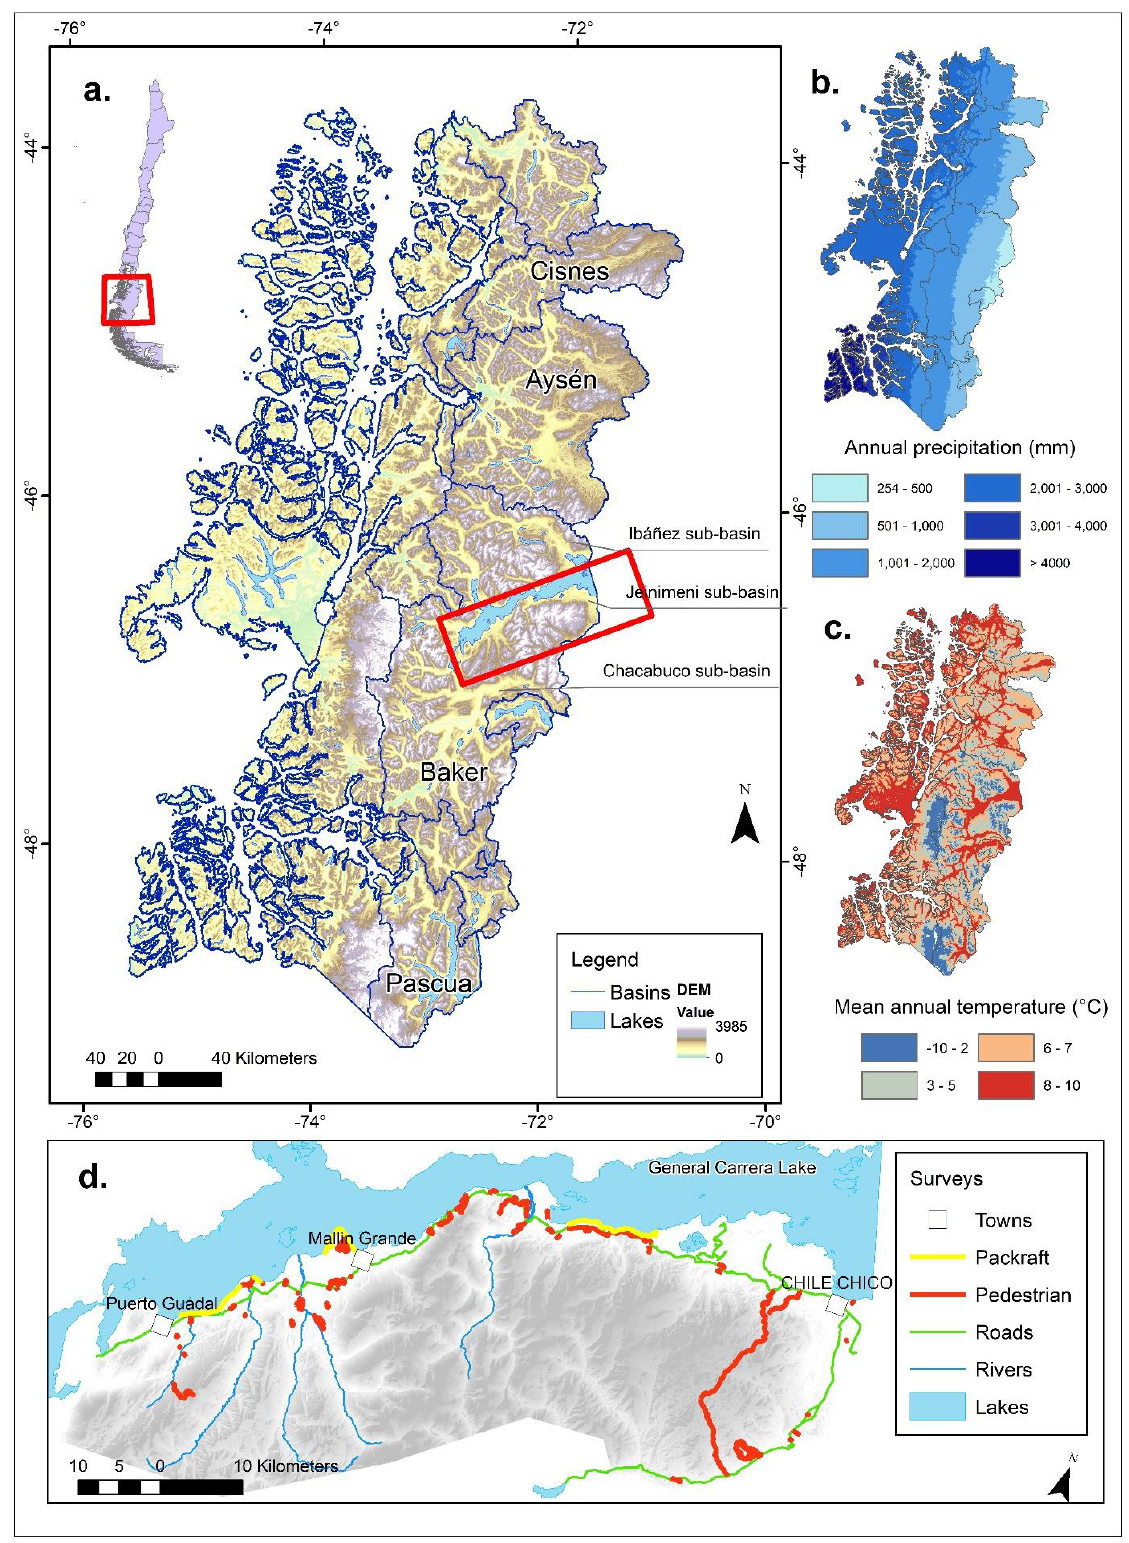
Figure 1. Map of the study area: ( a ) Central West Patagonia with information on its main basins, the small red box indicates region (a), and the red rectangle indicates study area (d); ( b ) raster representation of annual precipitation; ( c ) raster representation of mean annual temperature; ( d ) study area with the distribution of archaeological surveys.